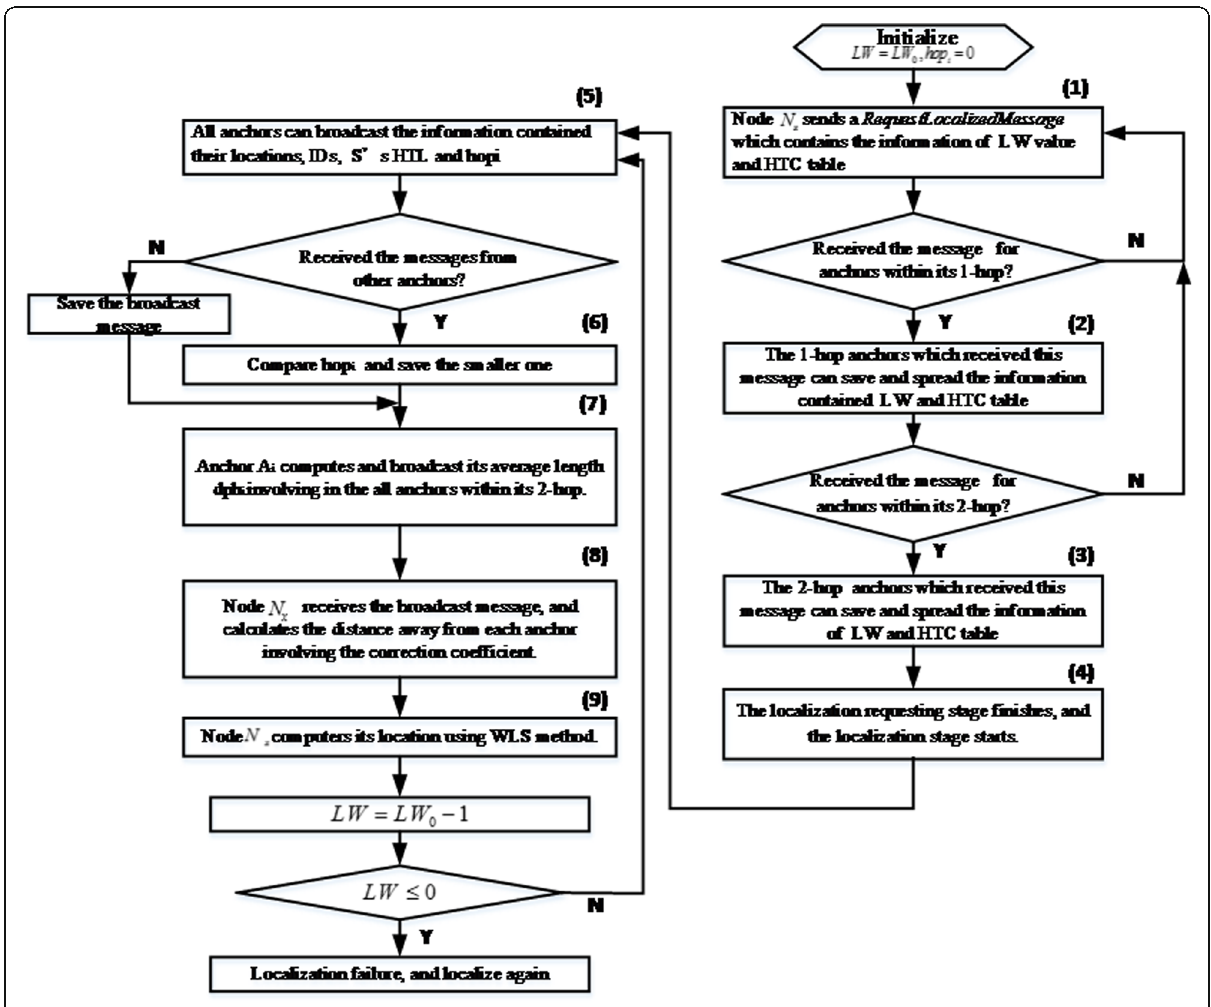
Fig. 3 The flow chart of IMDV-hop